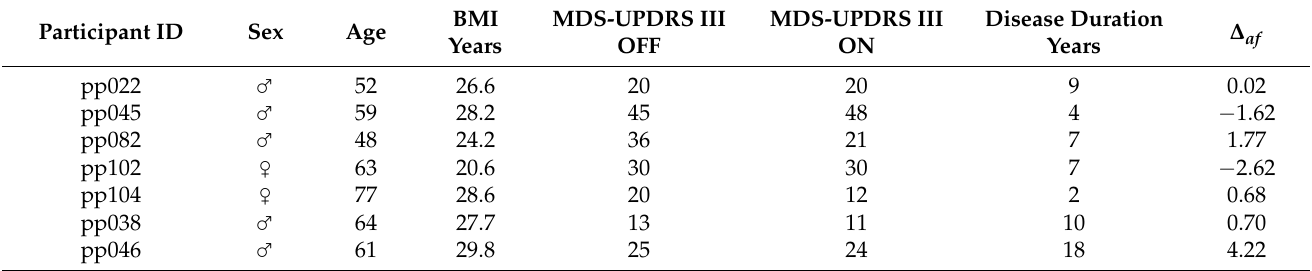
Table 6. Focus on seven PD patients performing the STS in “ON” and “OFF” medication states.